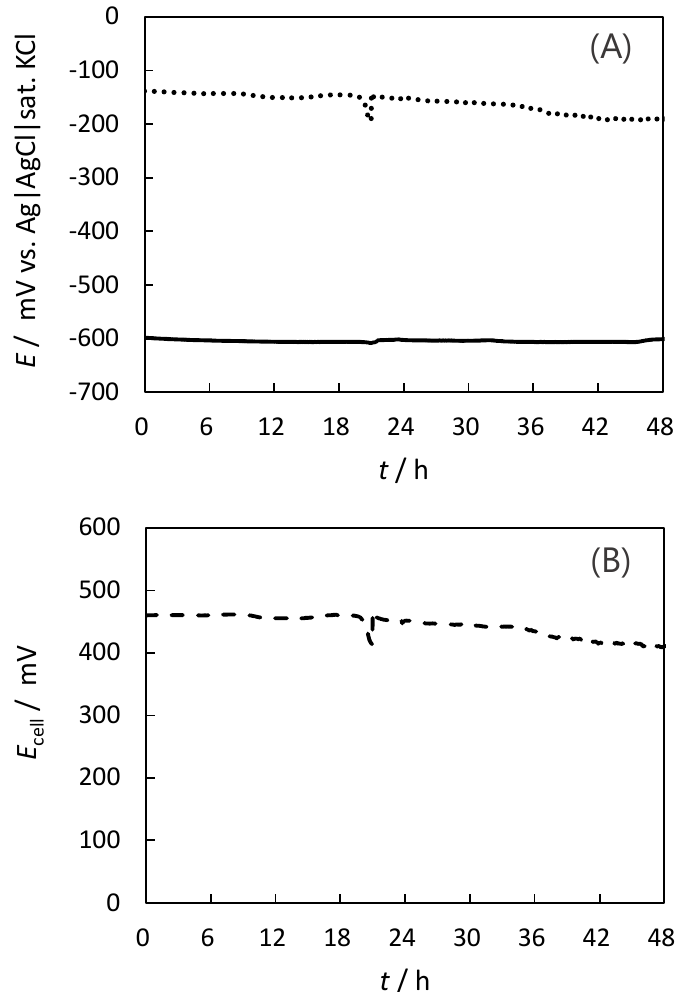
Figure 6. Continuous monitoring of the stability of the indigo-dye fermenting suspension biofuel cell with OCV measurements. ( A ) The measured potentials of the anode (solid line) and the cathode (dotted line) are plotted as a function of time. ( B ) The cell voltage (dashed line) is plotted as a function of time. The measurements were performed in the indigo-dye fermenting suspension at room temperature under quiescent and atmospheric conditions. The load resistance was 10 k Ω .